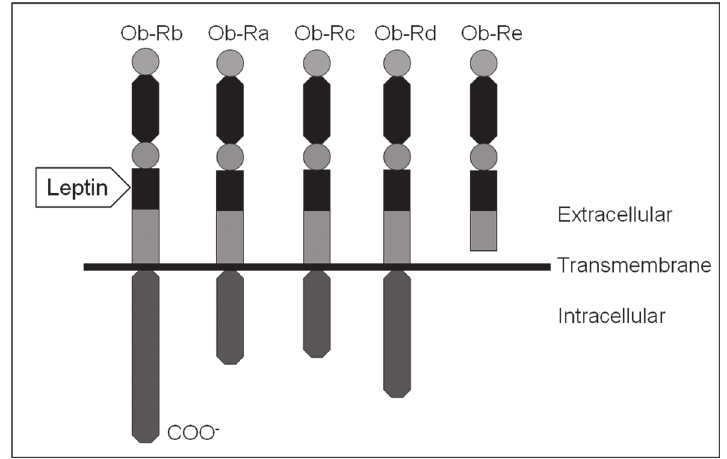
Figure 1. Representation of leptin receptor forms (Ob-R; subunits a to e). All share identical extracellular ligand-binding domains, but differ at the C-terminus. The long form of the Ob-R (Ob-Rb) is considered to be the active leptin receptor, activating the intracellular signal transduction pathway.